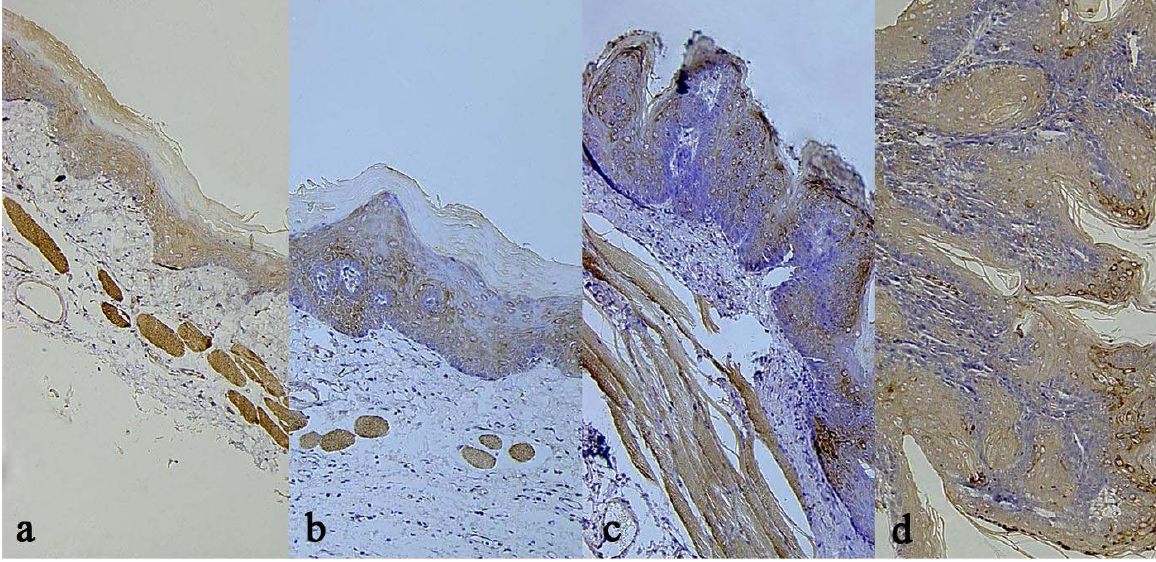
Figure 4. Tissue sections at 9 weeks corresponds VEGF immunostaining. ( a ). Dysplasia epithelium in the Treatment Group; ( b ). Dysplasia epithelium in the Model Group; ( c ). Squamous cell carcinoma in the Treatment Group; ( d ). Squamous cell carcinoma epithelium in the Model